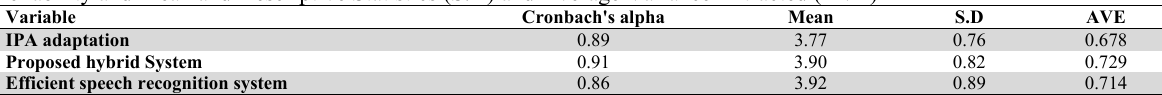
Reliability and Mean and Descriptive Statistics (S.D) and Average Variance Extracted (AVE) Variable